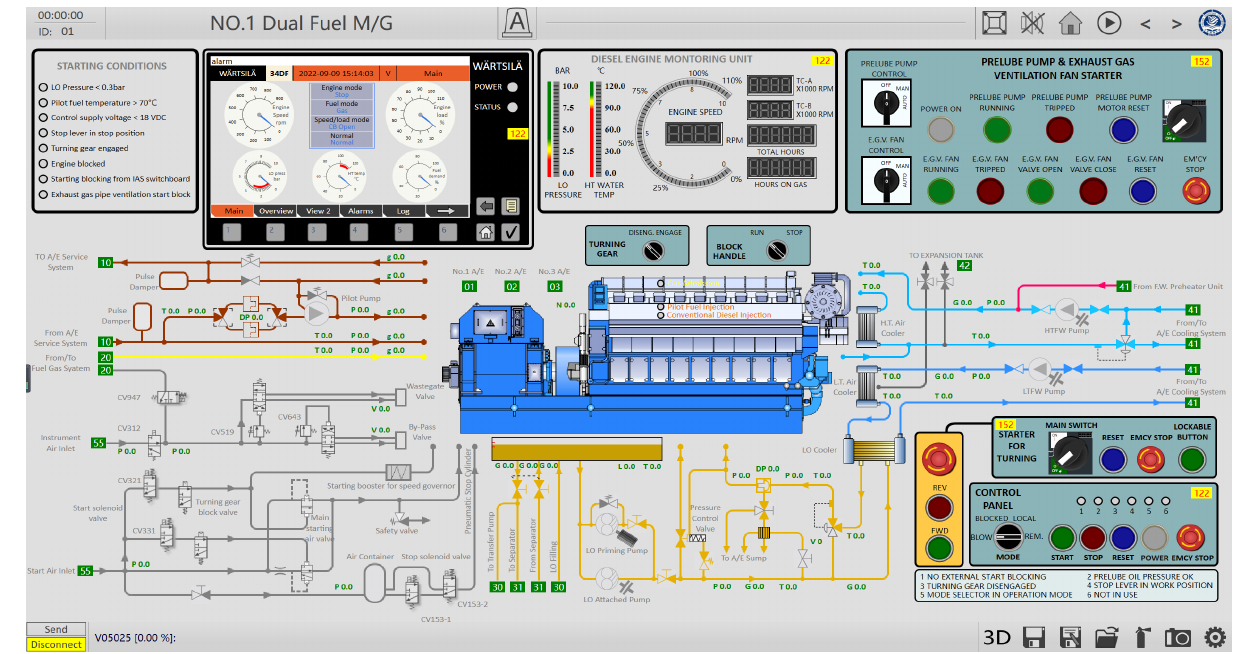
Figure 3. 2D page of dual fuel engine generator in marine engine room